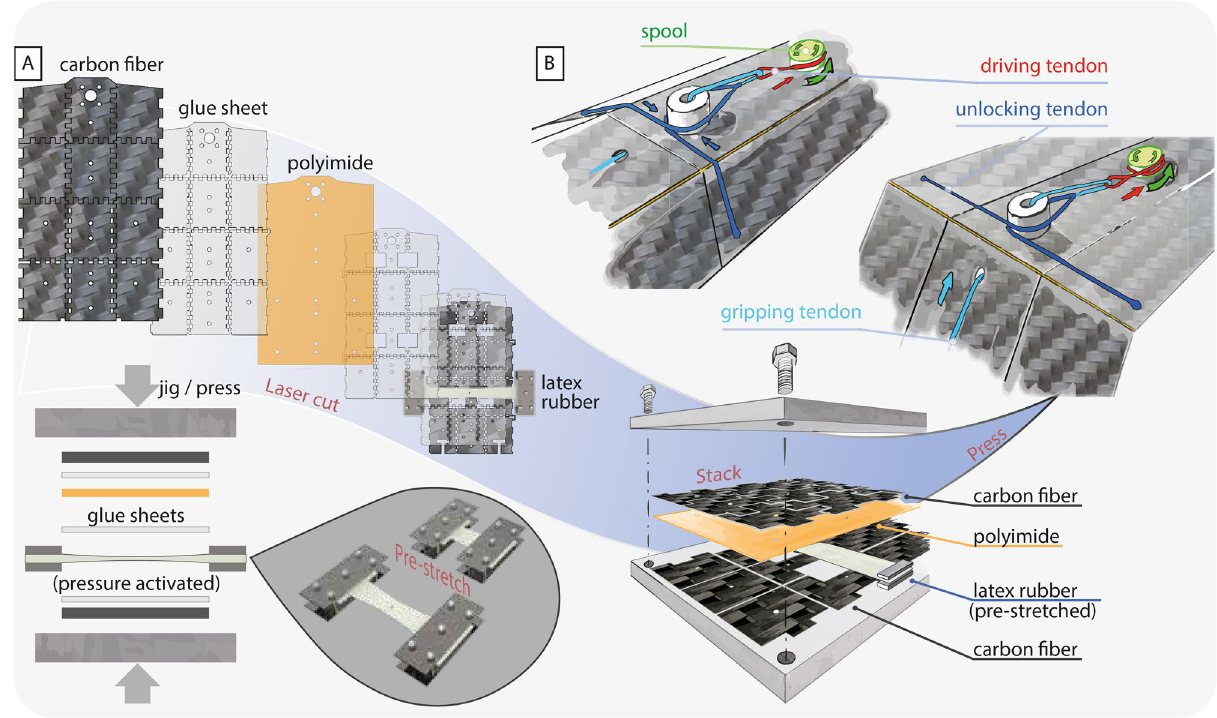
Figure 2. The metamorphic arm. ( A ) The manufacturing process of the morphing arm. The layers are laid on jigs with the elastic membranes pre-stretched before being pressed to form a single panel. ( B ) The actuation of the tri-tendon spool mechanism to unlock the arm. The directions of the tendon retractions are labeled with arrows of their respective